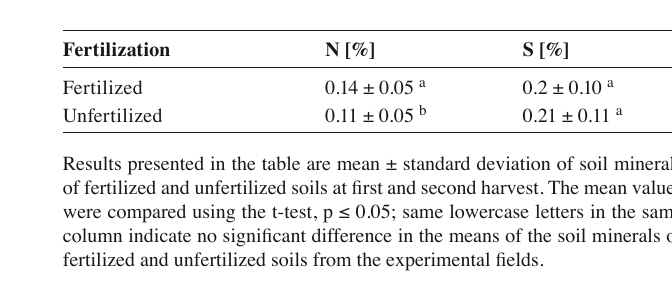
Tab. 5: Mineral composition of soil collected for Moringa oleifera acces - sions